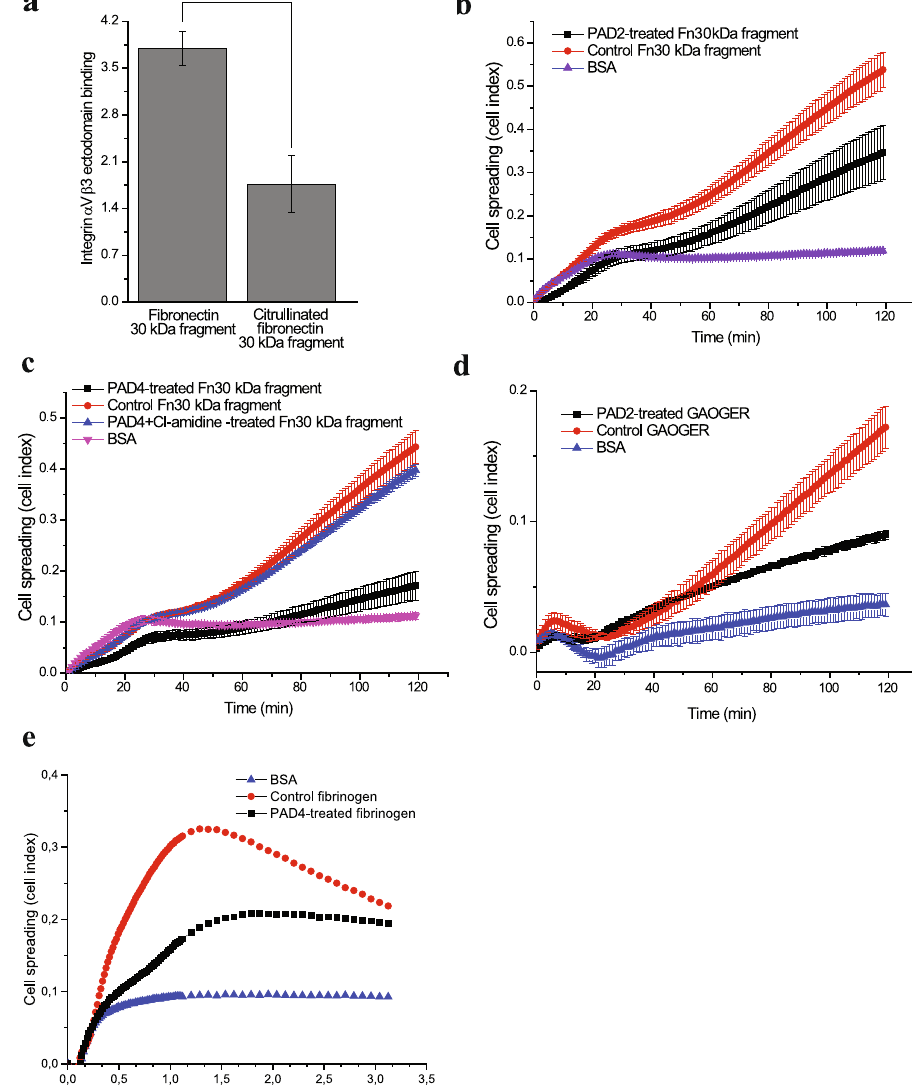
Figure 5. Citrullination inhibits integrin binding to isoDGR in fibronectin N-terminus and to GAOGER in collagen. ( a ) The binding of integrin α V β 3 ectodomain to citrullinated or control fibronectin N-terminal 30 kDa fragment. P-value between fibronectin (n = 3) and citrullinated fibronectin (n = 5) was calculated with two-tailed Student’s t-test from the mean values of three individual experiment normalized by background signal (BSA). Error bars show SEM. ( b ) Attachment and spreading of fibroblast like synoviocytes to PAD2- treated fibronectin N-terminal 30 kDa fragment real-time monitored by xCELLigence technology. BSA was the background control. Values are means ± SD of 3 parallel measurements from a single experiment. ( c ) Attachment and spreading of fibroblast like synoviocytes to PAD4-treated, control-treated (no enzyme) and PAD4 with inhibitor (Cl-amidine) –treated fibronectin N-terminal 30 kDa fragment real-time monitored by xCELLigence technology. BSA was the background control. Values are means ± SD of 3 parallel measurements from a single experiment. ( d ) Attachment and spreading of fibroblast like synoviocytes to PAD2-treated GAOGER assayed as above. ( e ) Attachment and spreading of fibroblast like synoviocytes to PAD4-treated fibrinogen assayed as above. Values are means ± SD of 3 parallel measurements from a single